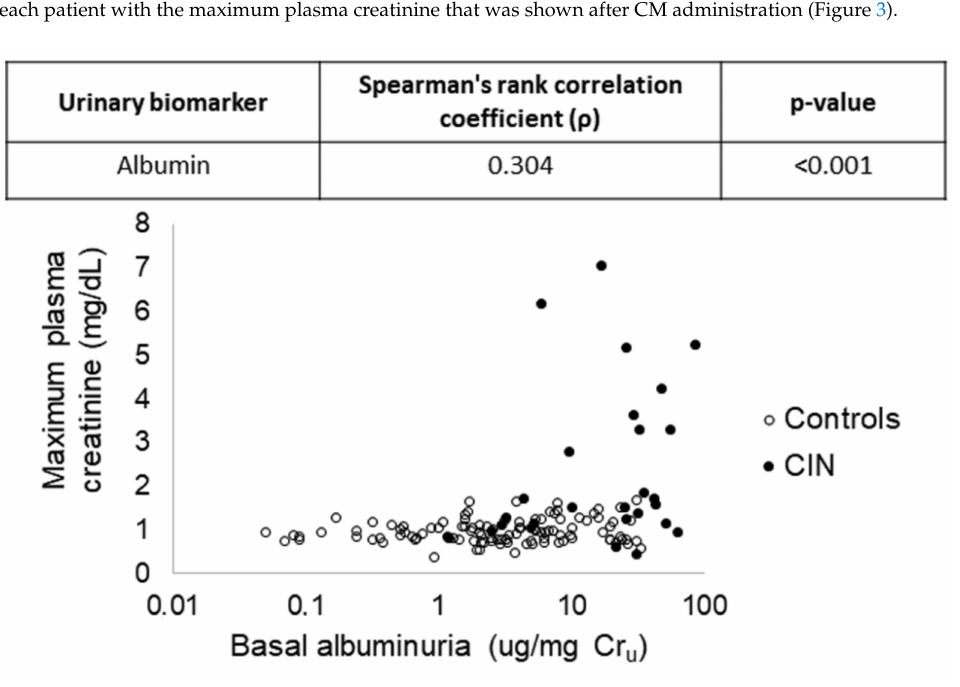
Figure 3. Results of the correlation analysis carried out between the urinary levels of albumin before con-trast media administration and the maximum plasma creatinine achieved after contrast media administration. CIN: contrast-induced nephropathy; Cru: urinary